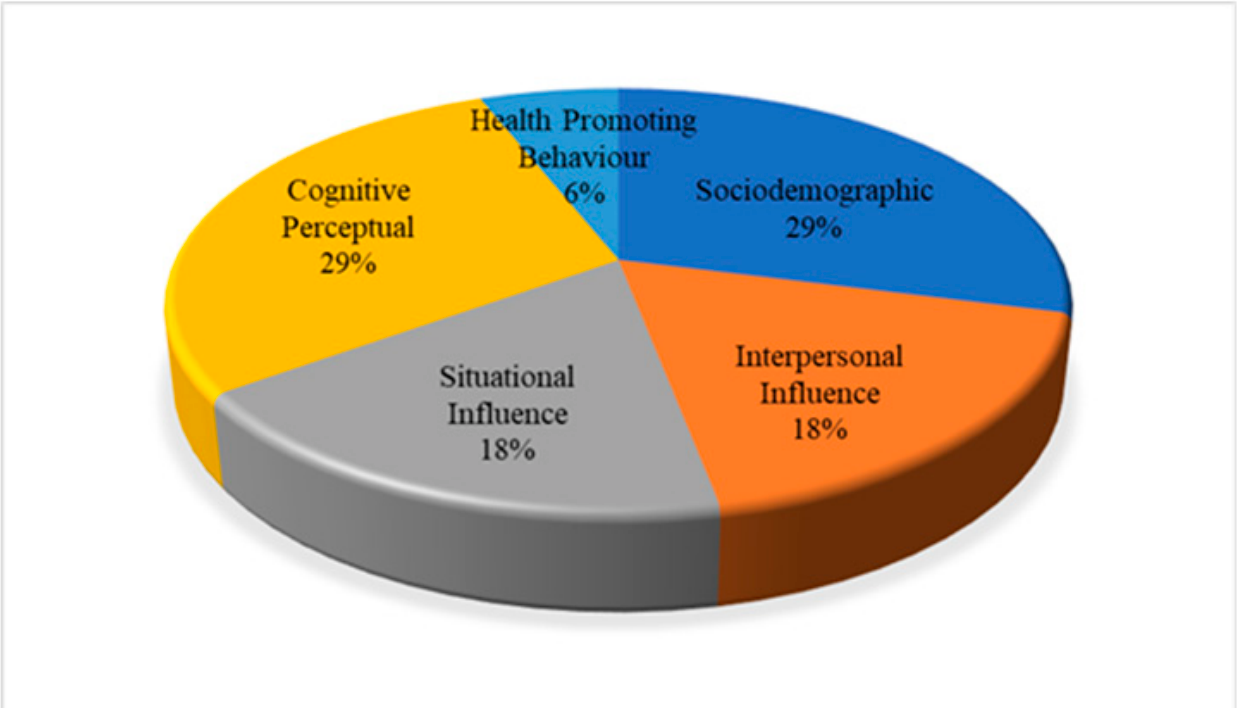
Figure 2. Percentage distribution of themes.